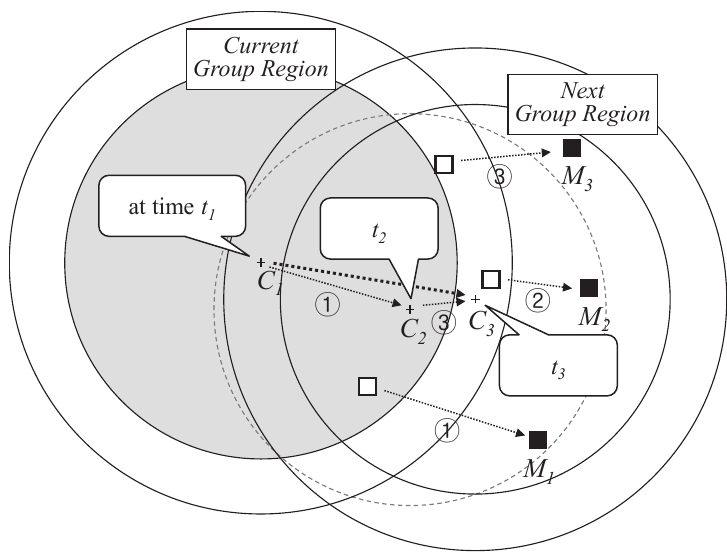
Figure 6. Combining locations of deviated sinks for interval time between data